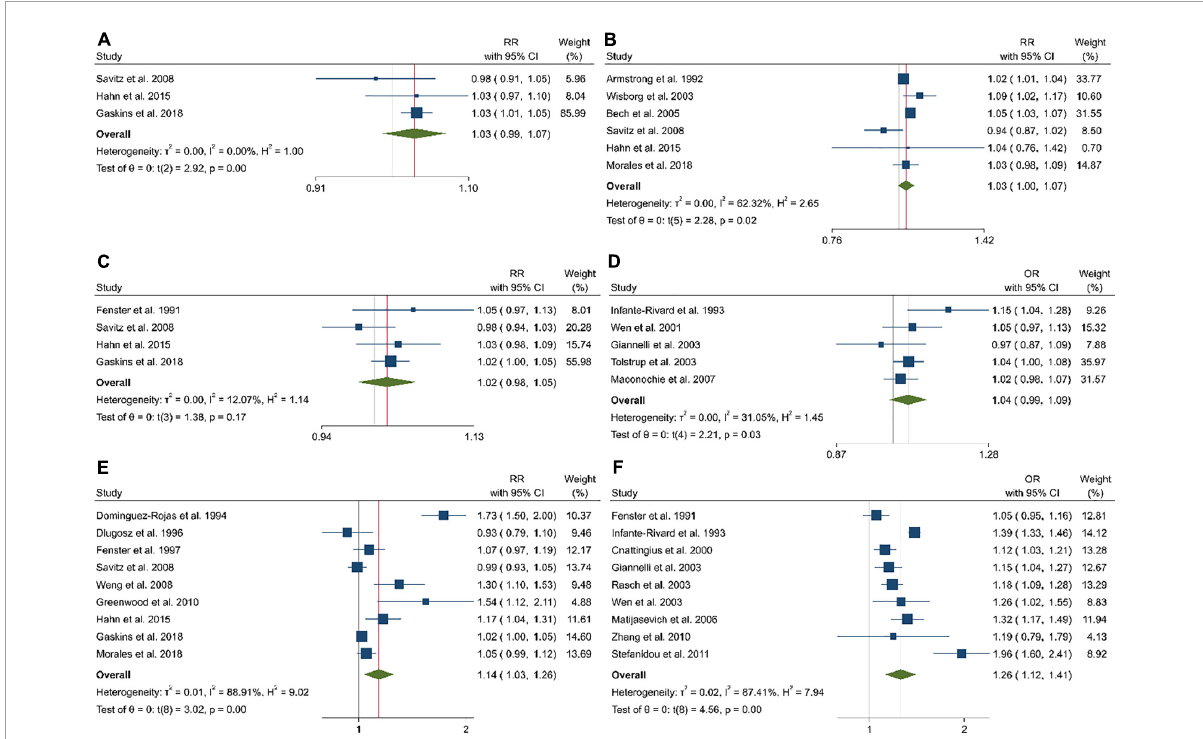
FIGURE3 The linear dose–response analysis between the risk of pregnancy loss and one cup of coffee intake before pregnancy in cohort studies (A) , one cup of coffee intake during pregnancy in cohort studies (B) , 100 mg caffeine intake before pregnancy in cohort studies (C) , 100 mg caffeine intake before pregnancy in case-control studies (D) , 100 mg caffeine intake during pregnancy in cohort studies (E) , and 100 mg caffeine intake during pregnancy in case-control studies (F) .